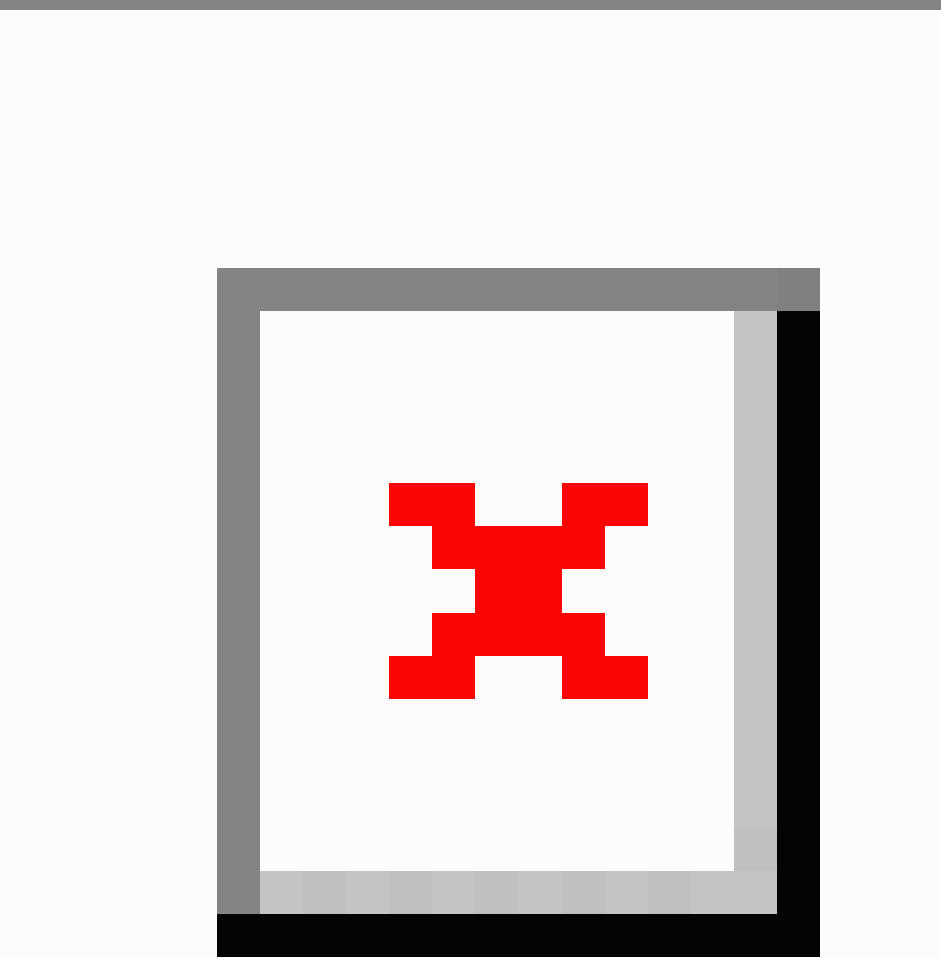
Figure 2. Screenshots from the Panoply platform, illustrating the tutorial panel, the debug dashboard, and the reframe